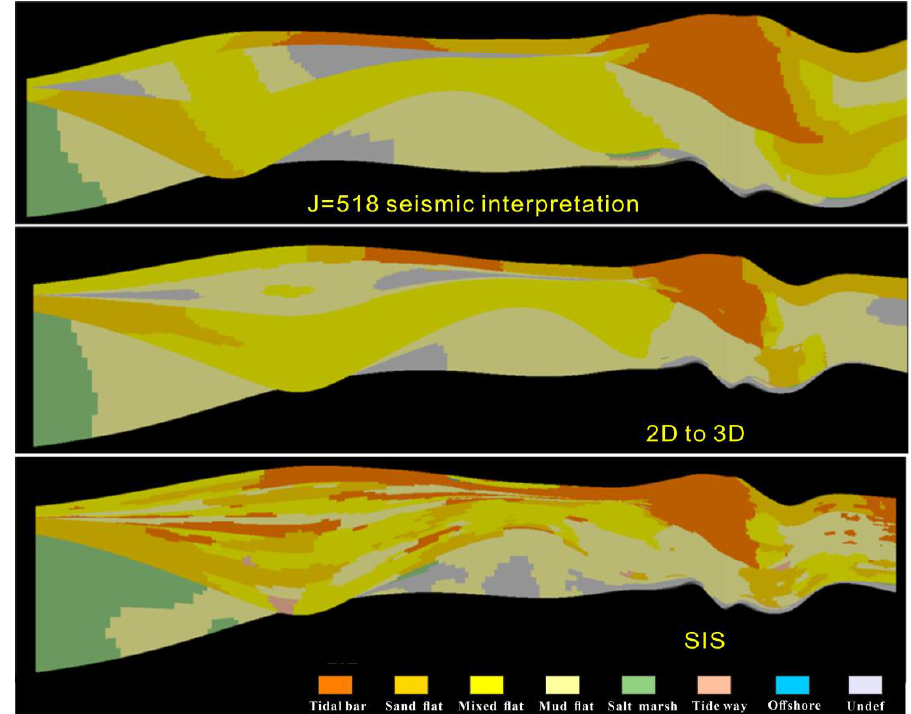
error of the tidal bar is 11.5%, and the error range is 0% – 42.2%. The average error is 12.1%, Figure 15. Comparison of seismic interpretation section and prediction results. and the range of error is 0% – 51.6%.